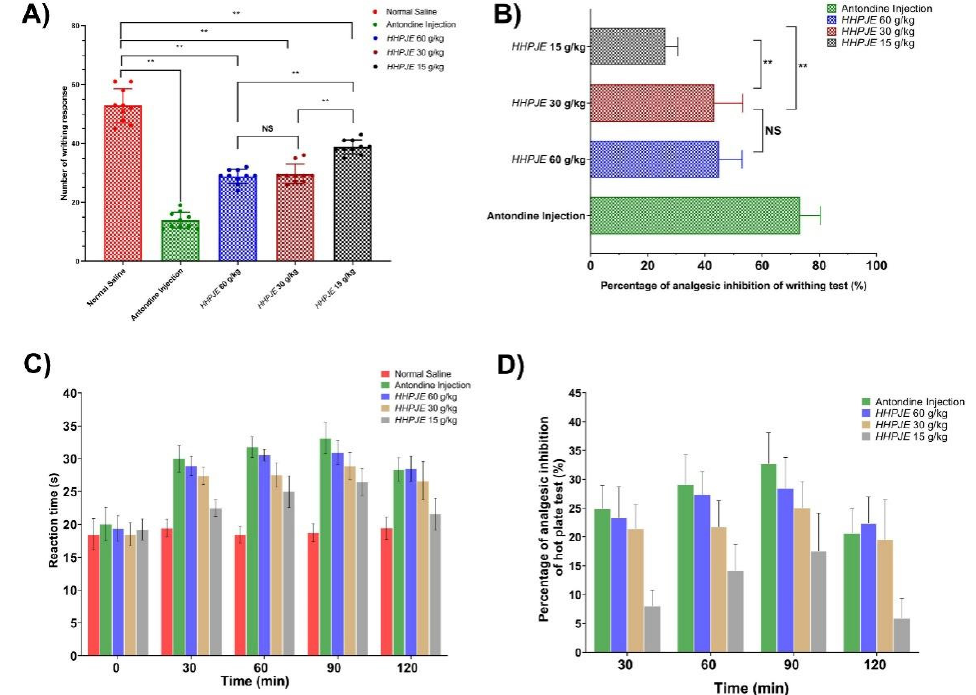
Figure 3. Analgesic activity of HHPJE. ( A ) Change in writhing response induced by acetic acid; ( B ) Percentage of analgesic inhibition of writhing test; ( C ) Changes in reaction time within 0 to 120 min in hot plate test; ( D ) Percentage of analgesic inhibition of hot plate test. Values were expressed as the mean ± SD, and all data were analyzed using one-way ANOVA followed by multiple comparisons. ** represents extremely significantly different between two groups ( p < 0.01), while NS means no significant differences ( p > 0.05).